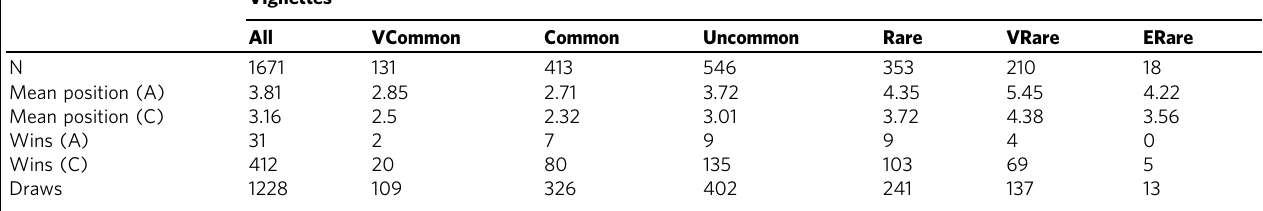
Table 1 Position of true disease in ranking strati fi ed by rareness of disease.